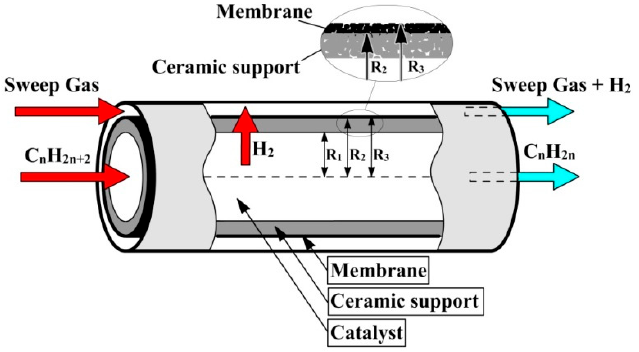
Figure 1. The scheme of the catalytic membrane reactor for the alkane